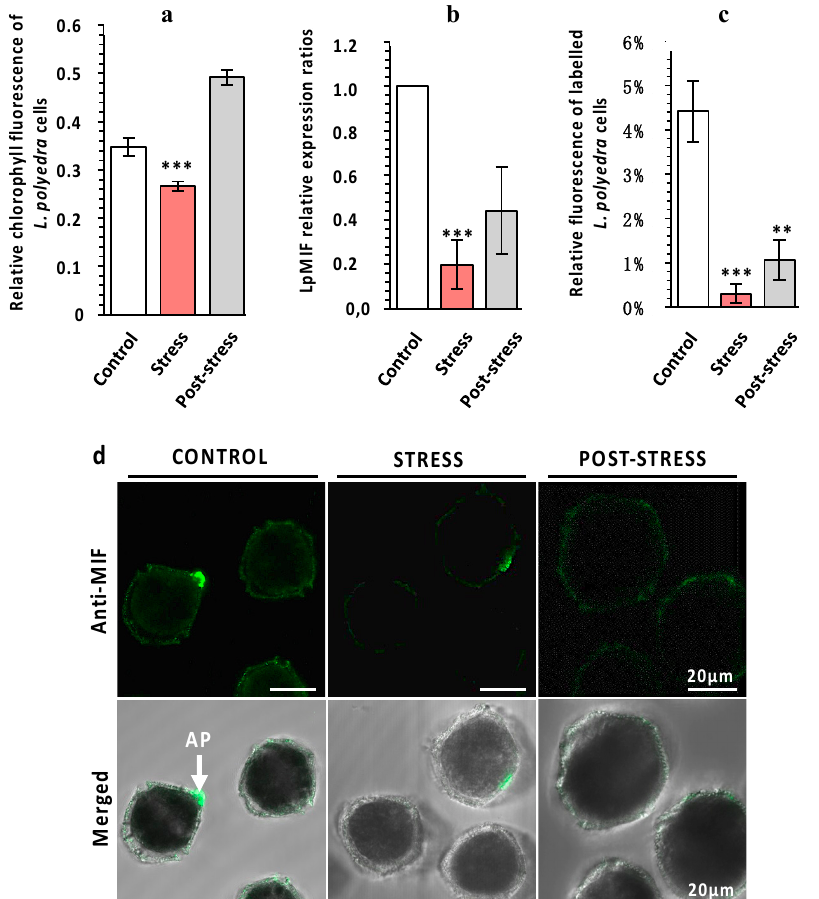
Figure 3. LpMIF expression during a stress response. ( a ) The exposure of L. polyedra to copepods decreases photosynthetic activity as a stress response. Chlorophyll fluorescence parameters were measured with a Multi-Color Pulse-Amplitude-Modulated fluorometer (Heinz Walz Gmbh, Effeltrich, Germany). Photosystem II activity was calculated from the ratio of variable fluorescence to maximum chlorophyll fluorescence (Fv/Fm). Values are means (+/ − SEM) from three independent measurements/experiments. Asterisks indicate statistical differences (*** p < 0.001), according to Kruskal-Wallis test. ( b ) Relative expression ratios (normalized to control) of LpMIF in L. polyedra cells before (control), during (stress), and after (post-stress) exposure to copepods. Asterisks indicate statistical differences (*** p < 0.001), according to Kruskal-Wallis test. ( c ) Relative fluorescence of MIF-labelled L. polyedra cells expressed as the fluorescent area/total area, of cells before (control), during (stress), and after (post-stress) exposure to copepods ( n = 9 per sample; Kruskal-Wallis test: ** = p ≤ 0.01, *** = p ≤ 0.001). ( d ) Representative pictures of MIF-labelled L. polyedra before (control), during (stress), and after (post-stress) exposure to copepods. Images in the upper row are fluorescence micrographs (Anti-MIF) that were merged in the lower row with transmission light micrographs (Merged). Negative control samples directly exposed to the secondary antibody are shown in the Figure S2.